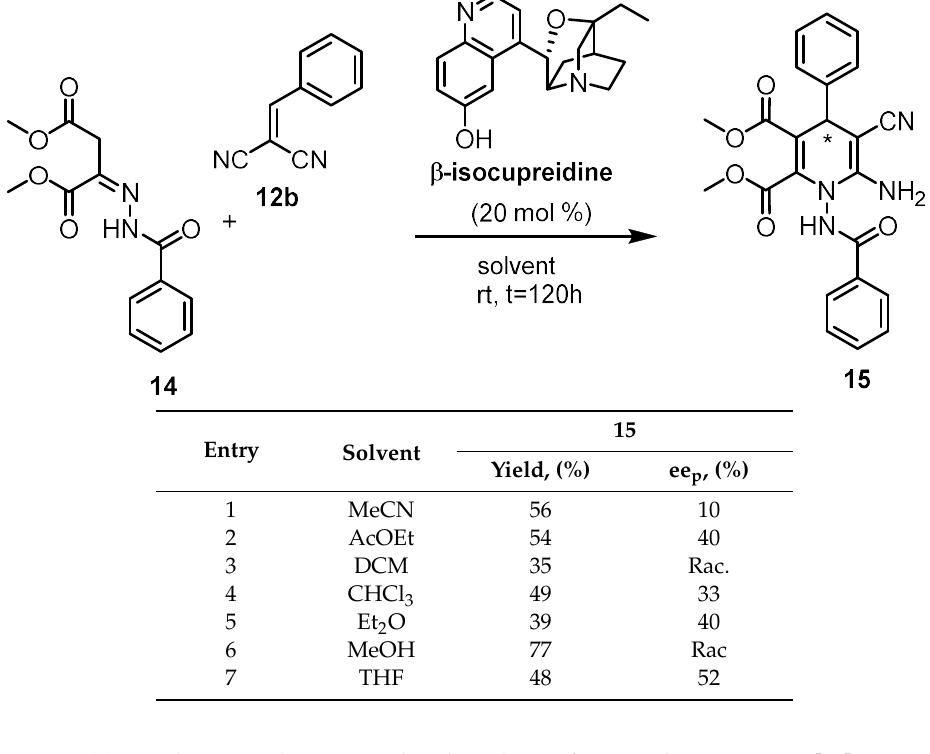
Table 7. β-isocupreidine catalysed synthesis of highly functionalised 1-benzamido1,4- dihydropyridine derivatives 15 [61].